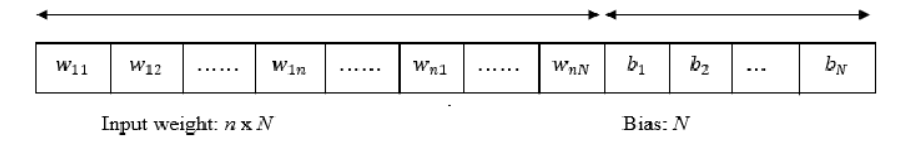
Figure 5. Vector structure of salp in